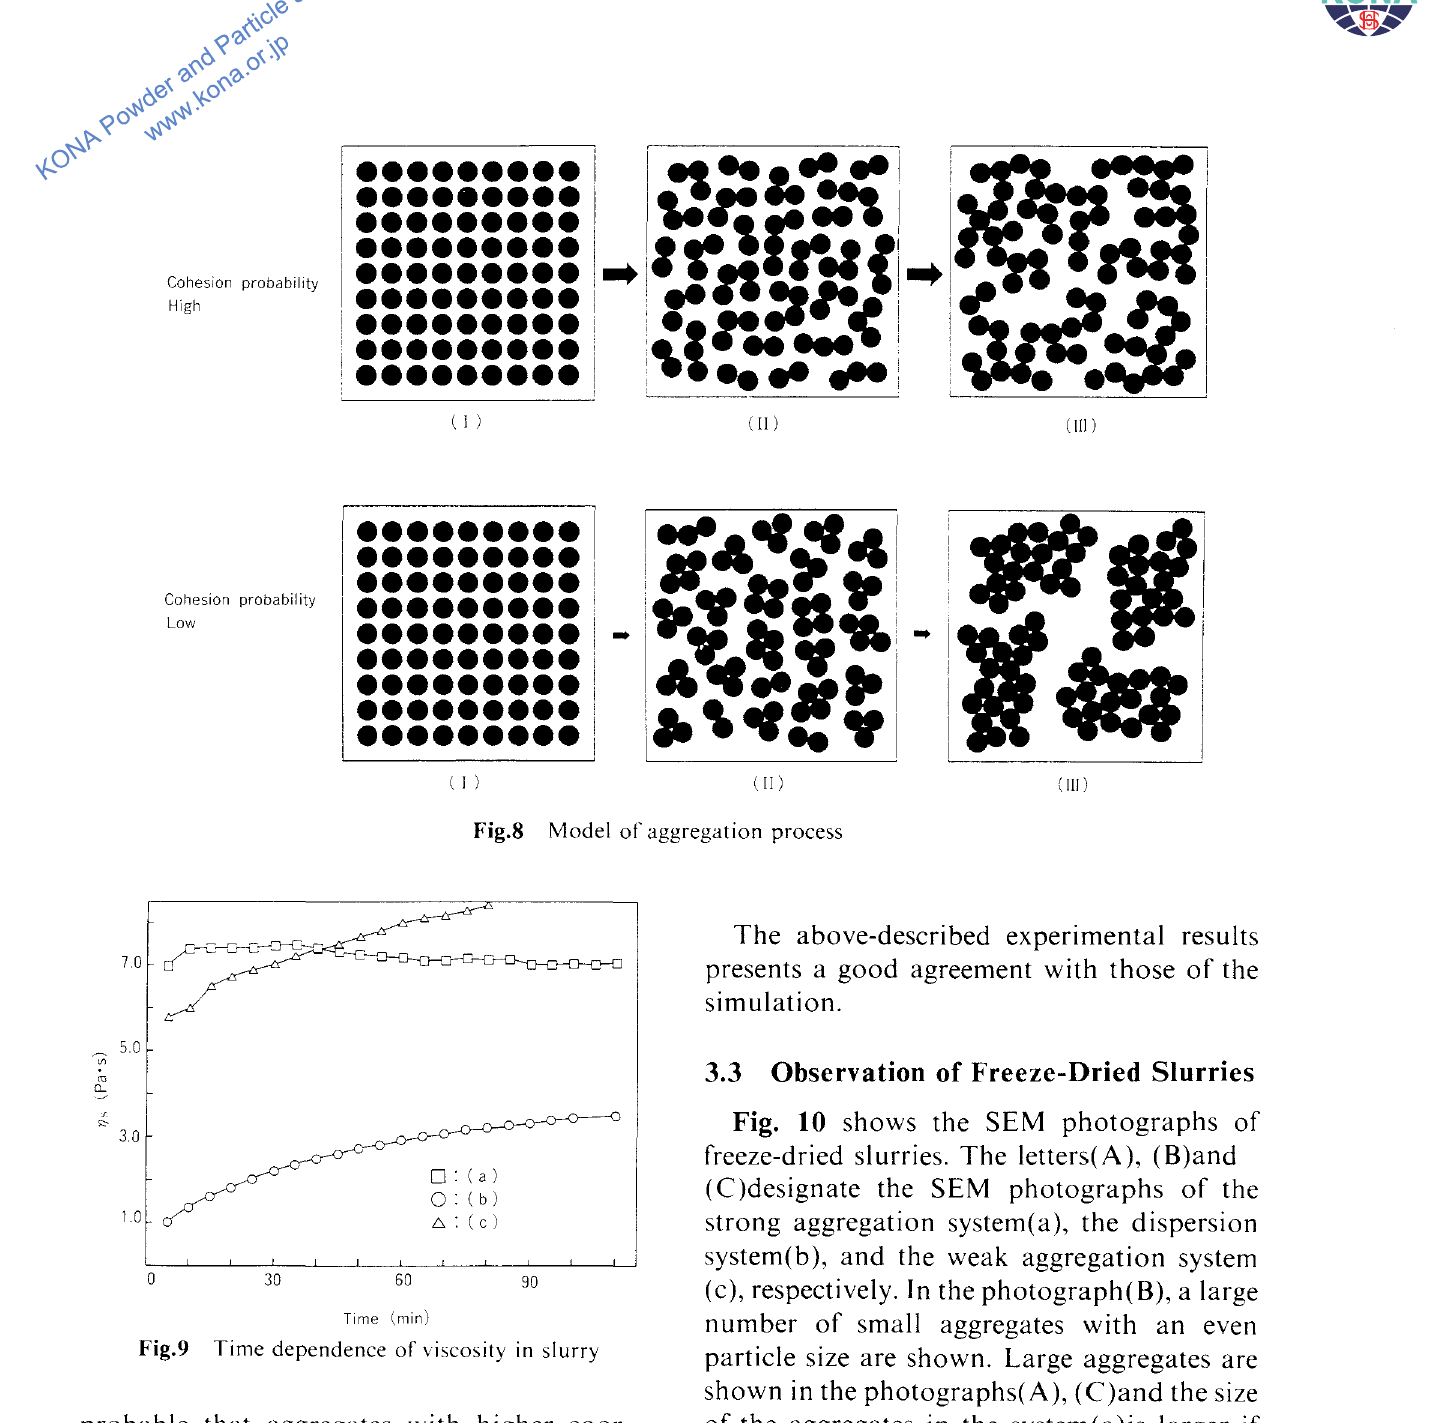
Fig.9 Time dependence of viscosity in